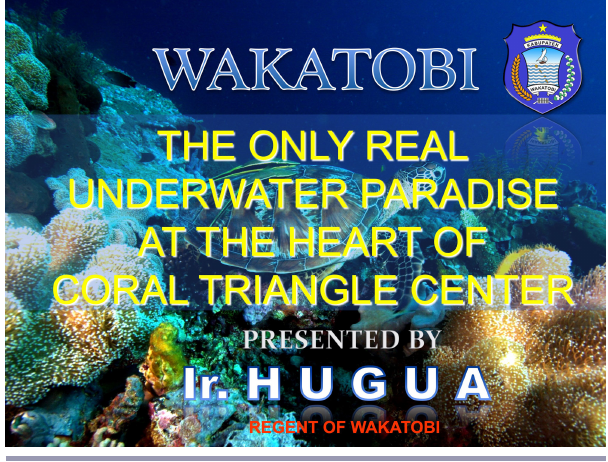
Fig. 4 . Title of slide